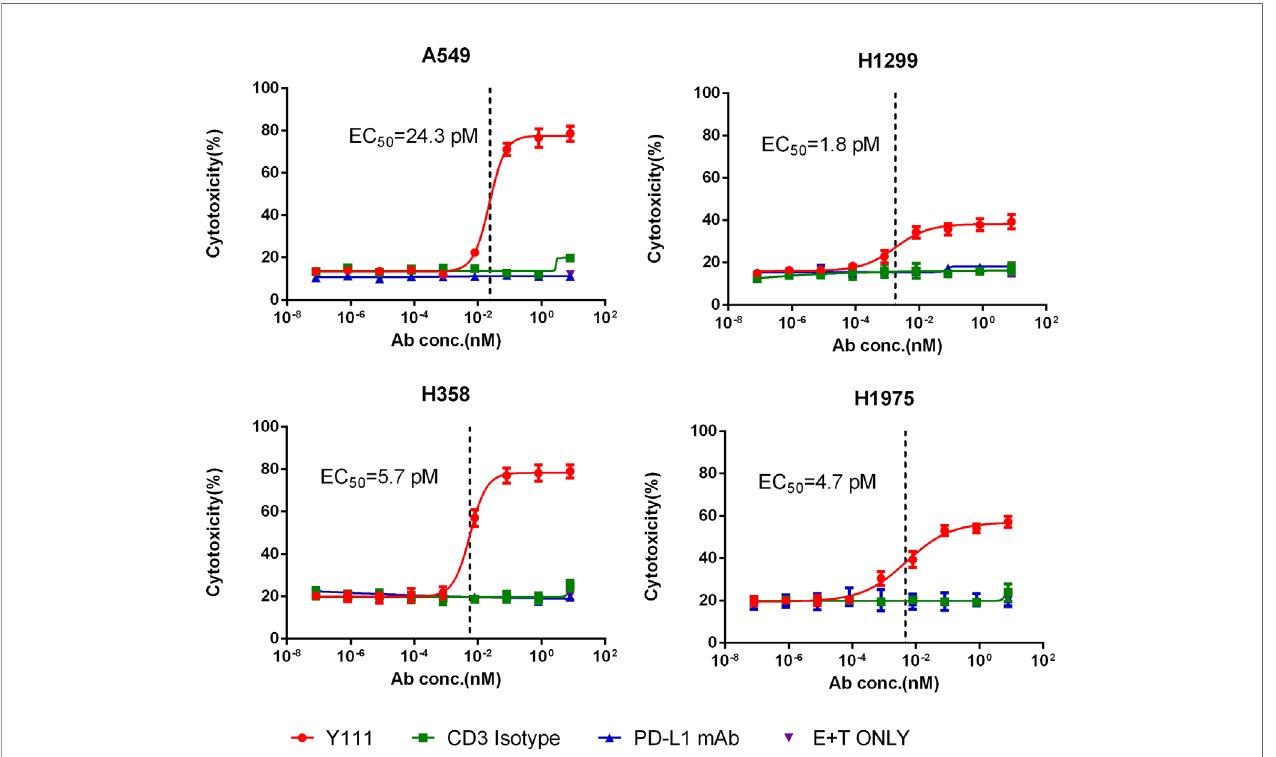
FIGURE 5 | Y111 redirected V g 2V d 2 T cells to kill PD-L1 positive NSCLC cell lines in vitro . The expanded and puri fi ed V g 2V d 2 T cells were incubated with four NSCLC cell lines, including A549, H1299, H1975, and H358, in a 1:1 ratio with the Y111 in a range of concentrations, CD3 Isotype or PD-L1 mAb for 12 hours. Then the proportions of killed target cells were plotted against the antibody concentrations. These cell lines were PD-L1 positive shown in Supplementary Figure 6 . The calculated EC 50 values were shown. The data points in were represented as mean ± SEM among 9 individual subjects for the